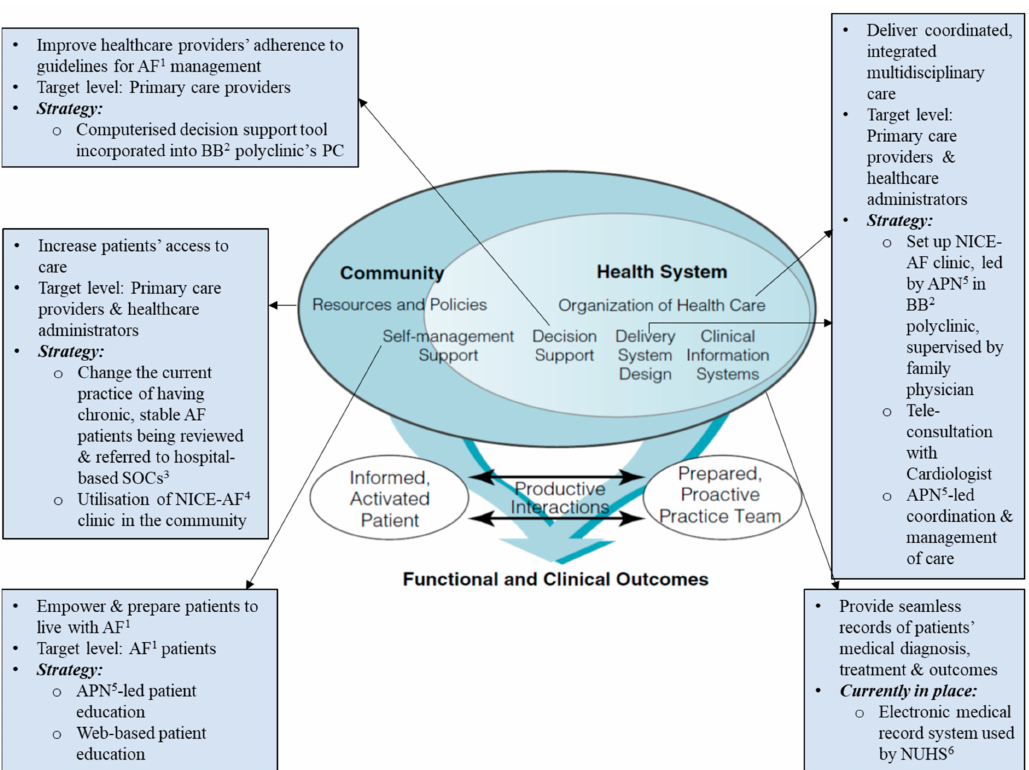
Figure 1. Elements of chronic care model guiding the design of the NICE-AF clinic. 1 Atrial